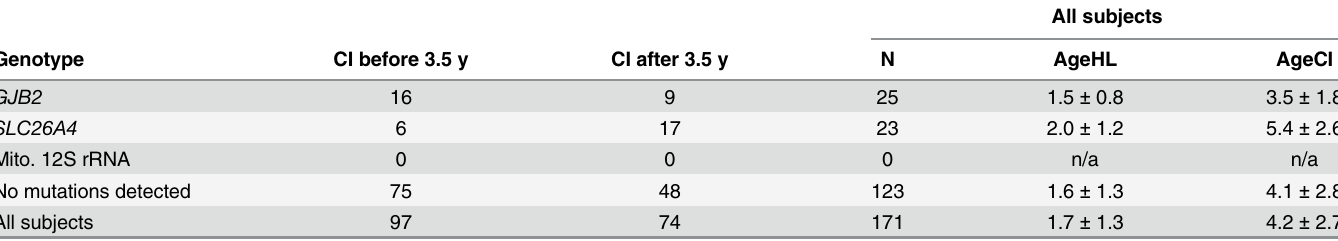
Table 4. Number of subjects with mutations in GJB2 , SLC26A4 and the mitochondrial 12S rRNA